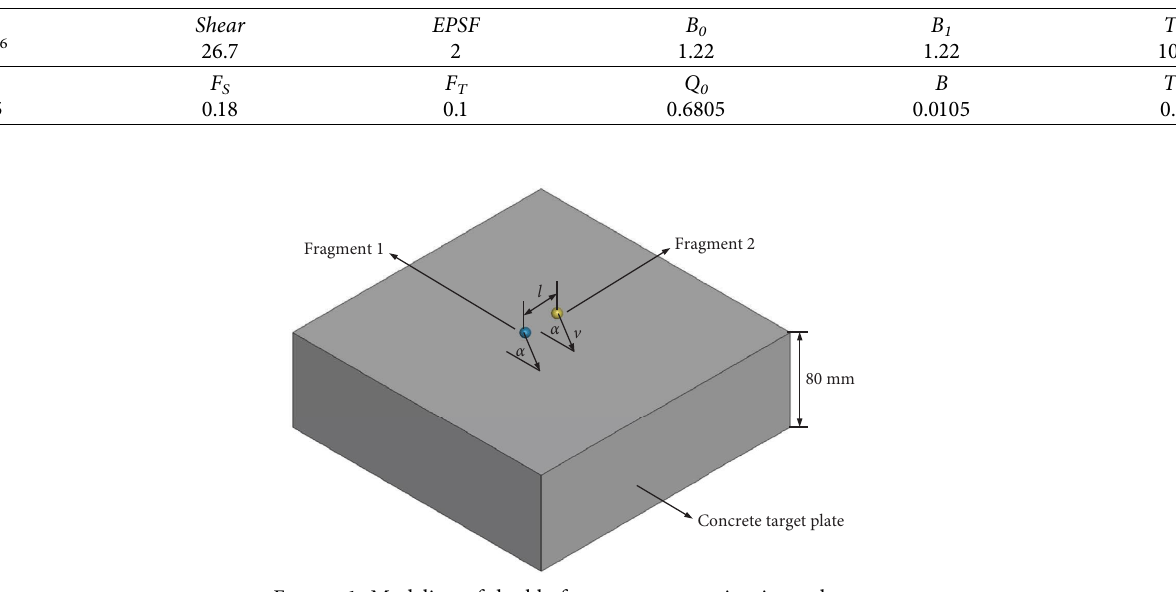
Table 2: RHT equation of state parameters.